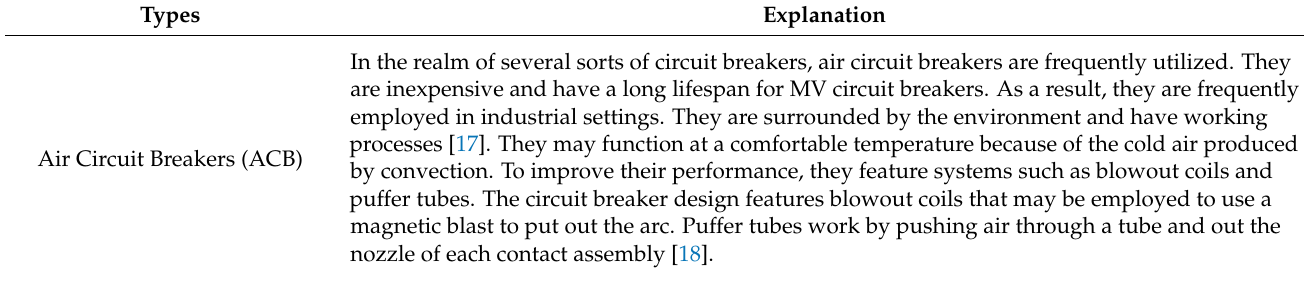
Table 2. Medium-voltage circuit breaker